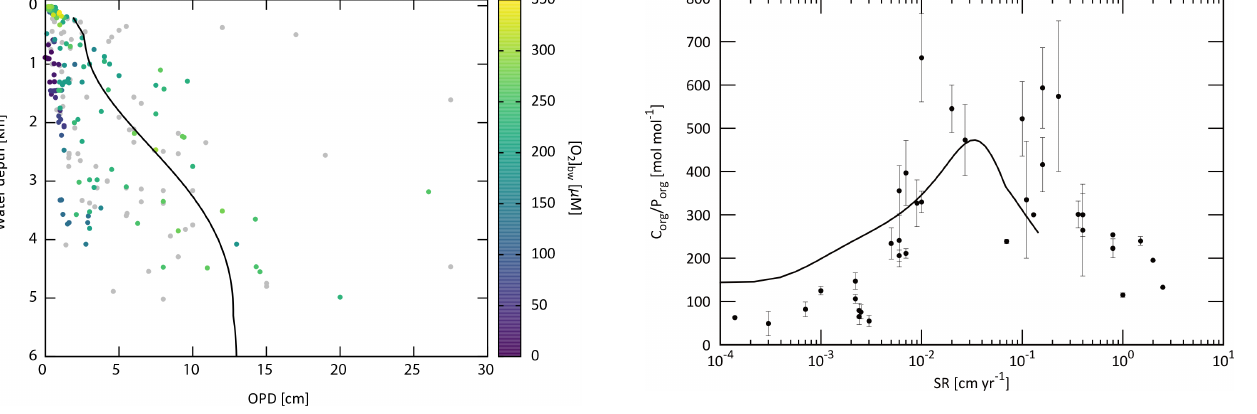
Figure 14. Oxygen penetration depth (OPD) as a function of wa- ter depth. Colored dots denote the observational data obtained from literature survey (Bradley et al., 2020; Donis et al., 2016; Nierop et al., 2017; Rowe et al., 2008; McManus et al., 2005; Martin and Sayles, 2014; Pfeifer et al., 2002; Hyacinthe et al., 2001; Hartnett et al., 1998; Hedges et al., 1999; Morford and Emerson, 1999; De- vol and Christensen, 1993; Gundersen and Jorgensen, 1990; Sachs et al., 2009). The color represents the O 2 concentration of bottom water, [O 2 ] bw , with gray dots for the unknown [O 2 ] bw value. The simulated OPD obtained from the reference run is shown as a black line.